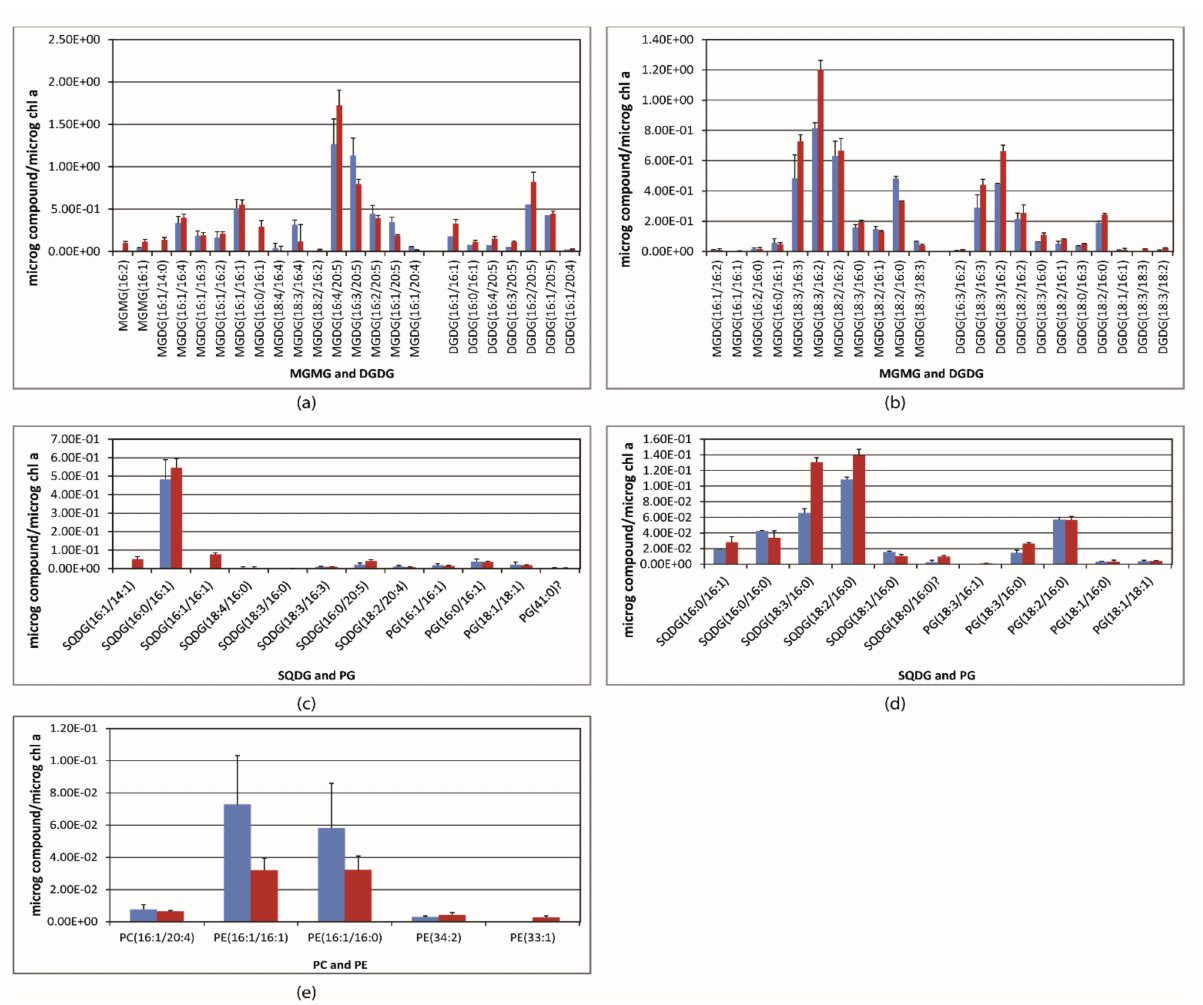
Figure 4. Content of the different glycerolipids detected in the extract of the algae H. spicula (panels a , b , c ) and M. vaginatus (panels d and e ). MGMG: monogalactosyl-monoacylglycerol; MGDG: monogalactosyldiacylglycerol; DGDG: digalacto- syldiacylglycerol; SQDG: sulfoquinovosyldiacylglycerol; PG: diacylglycererylphosphoglycerol; PC: diacylglycererylphos- phocholine; PE: diacylglycererylphosphoethanolamine. Values are the mean ± standard deviation of three independent cultures ( n = 3). Blue bars, low light; red bars, high light. See also Annex A in the supplementary